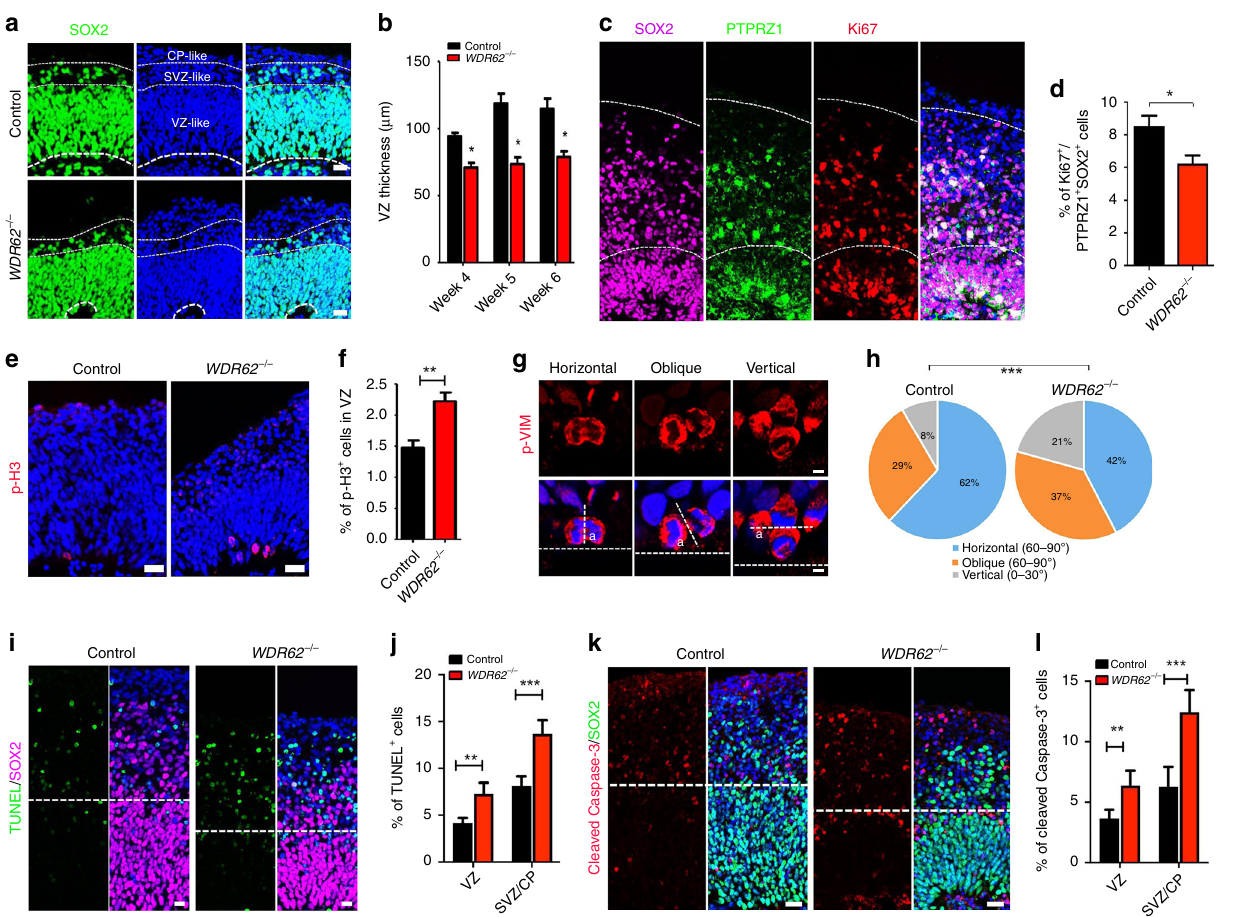
Fig. 2 Impaired mitosis, symmetric division, survival of NPCs in mutant organoids. a Confocal imaging of immunohistochemical (IHC) staining sections from week 6 cerebral organoids. Scale bars: 20 μ m. White dotted lines mark ventricular zone (VZ), subventricular zone (SVZ), and cortical plate (CP)-like areas. b Quanti fi cation of SOX2-positive VZ thickness in organoids. c Representative imaging of IHC staining from week 12 control cerebral organoids. Regions below bottom white dotted lines represent VZ/SVZ-like regions. Hoechst stains nuclei (blue). Scale bars: 20 μ m. d Quanti fi cation of Ki67-positive out of total PTPRZ1- and SOX2-double positive cells ( n > 50 cells counted in each experiment). e , g , k Representative imaging of IHC staining of week 6 organoid sections with antibodies listed. Above and below white dotted lines in K represent SVZ/CP- and VZ-like regions, respectively. Hoechst stains nuclei (blue). Scale bars: 20 μ m in ( e ), 5 μ m in ( g ), and 10 μ m in ( k ). f , h , l Quanti fi cation of the percentage of p-H3 ( f ), division angle ( h ), and percentage of Caspase-3-positive cells in the VZ-like or SVZ/CP-like regions in week 6 organoid sections. i Representative imaging of TUNEL staining in week 6 organoid sections. j Quanti fi cation of the percentage of TUNEL-positive cells. Error bars represent SEM of results from three independent cerebral organoids (three sections from each organoid); * P < 0.05, *** P < 0.001 (Student ’ s t-test). In h , *** P < 0.001 (Mann – Whitney mutant cells (Fig. 3b). Wdr62 heterozygous mice were viable and